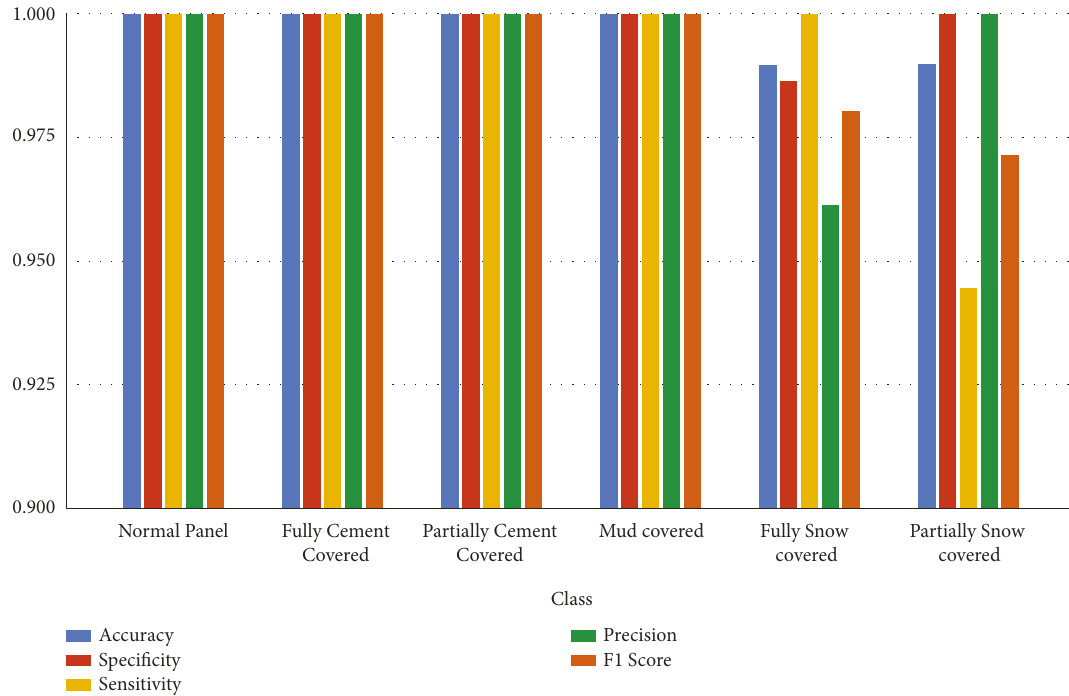
Figure 13: Statistical measures for